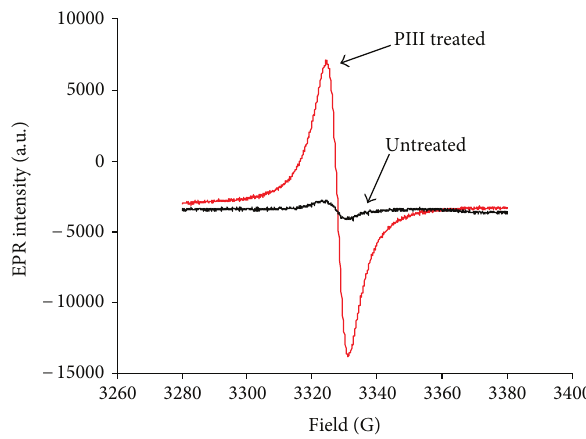
F 5: FTIR ATR spectra of LDPE aer PIII treatment. ick array shows �uence increase of PIII treatment: from untreated to 10 . e spectra were recorded aer stabilization during 2 weeks storage time aer PIII treatment. e intensity of unsaturated and oxygen-containing group lines increases with �uence of PIII.